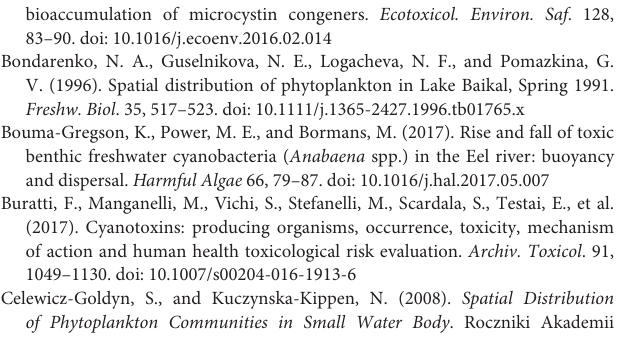
Supplementary Table 2 | Time series data of 2017 water quality parameters for Pond 1 and Pond 2. Supplementary Table 3 | Time series data of 2018 water quality parameters for Pond 1 and Pond 2. Supplementary Table 4 | Descriptive statistics of phytoplankton functional groups. Supplementary Table 5 | Coefficient of variation values for Pond 1 and Pond